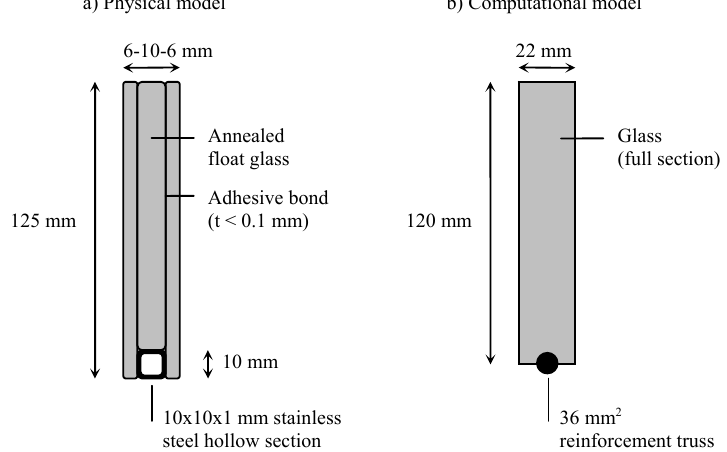
Figure 1: Cross sections of a) the physical beams and b) the computational